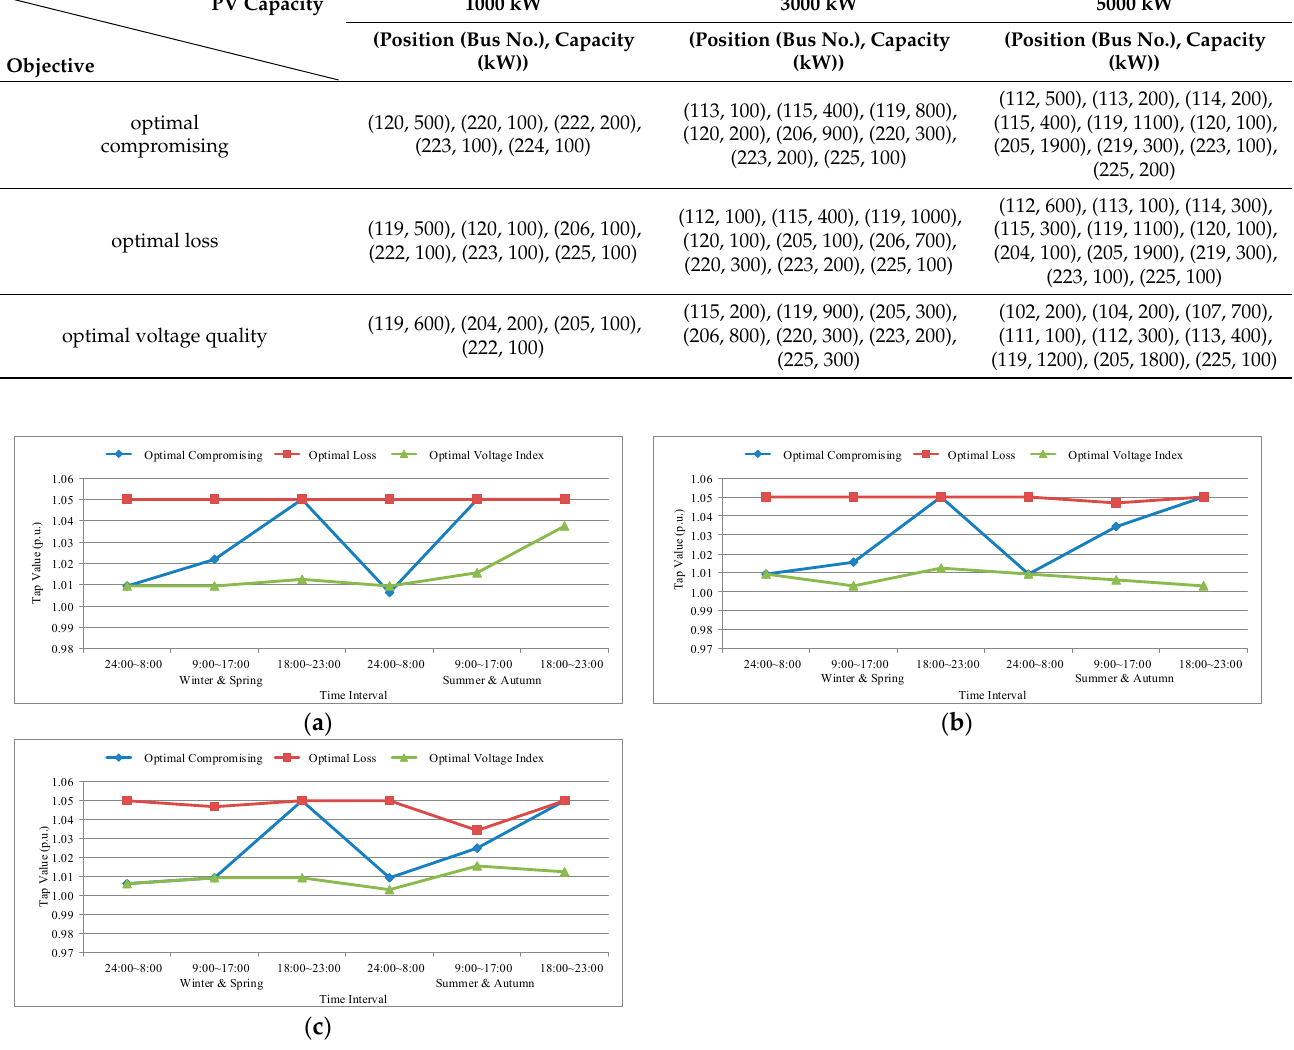
Figure 9. Tap values for the different objectives. ( a ) PV installed capacity 1000 kW; ( b ) PV installed capacity 3000 kW; ( c ) PV installed capacity 5000 kW.